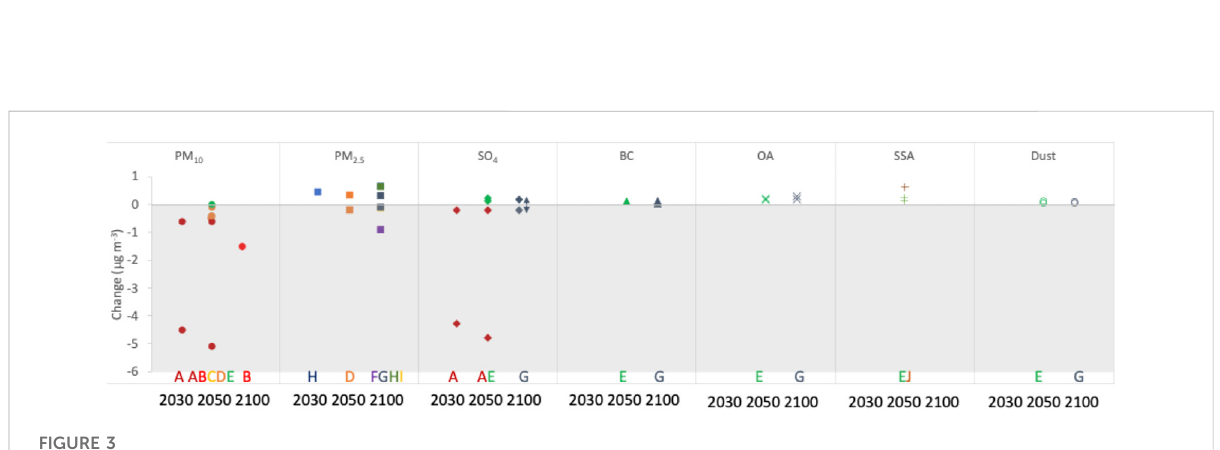
FIGURE 3 Model projections of PM and its components as calculated by the studies included in this assessment report. The changes are color- and symbol-coded by the studies; (A) Lacressonniere et al. (2014), (B) Juda et al. (2012), (C) Manders et al. (2012), (D) Lacressonniere et al. (2017), (E) Cholakian et al. (2019), (F) Lemaire et al. (2016), (G) Westerveld et al. (2016), (H) Silva et al. (2017), (I) Park et al. (2020), (J) Soares et al. (2016). Each study is represented by the lower and upper estimates of the projections if